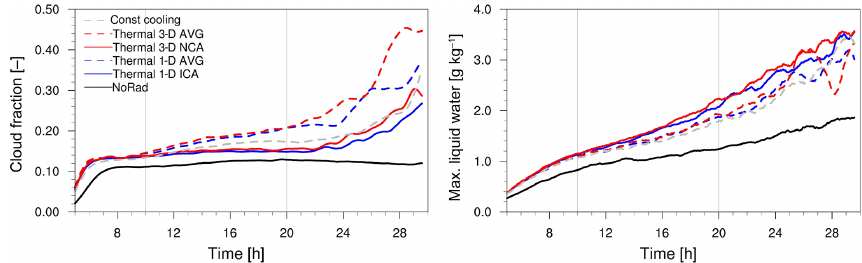
Figure 8. Time development of cloud fraction and maximum liquid water mixing ratio from 5 to 30h. The two gray lines (at 10 and 20h) separate the development in different periods for further analysis.